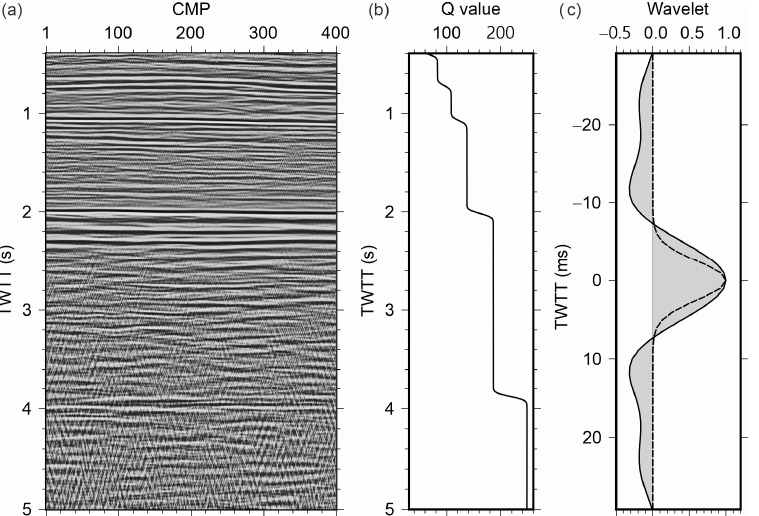
Figure 10. Field data example: ( a ) a fragment of a stacked real-data section; ( b ) interval Q model at CMP = 200; ( c ) the estimated wavelet (gray shading) and a simplified Gaussian wavelet (dotted line) used for shaping in ITD.